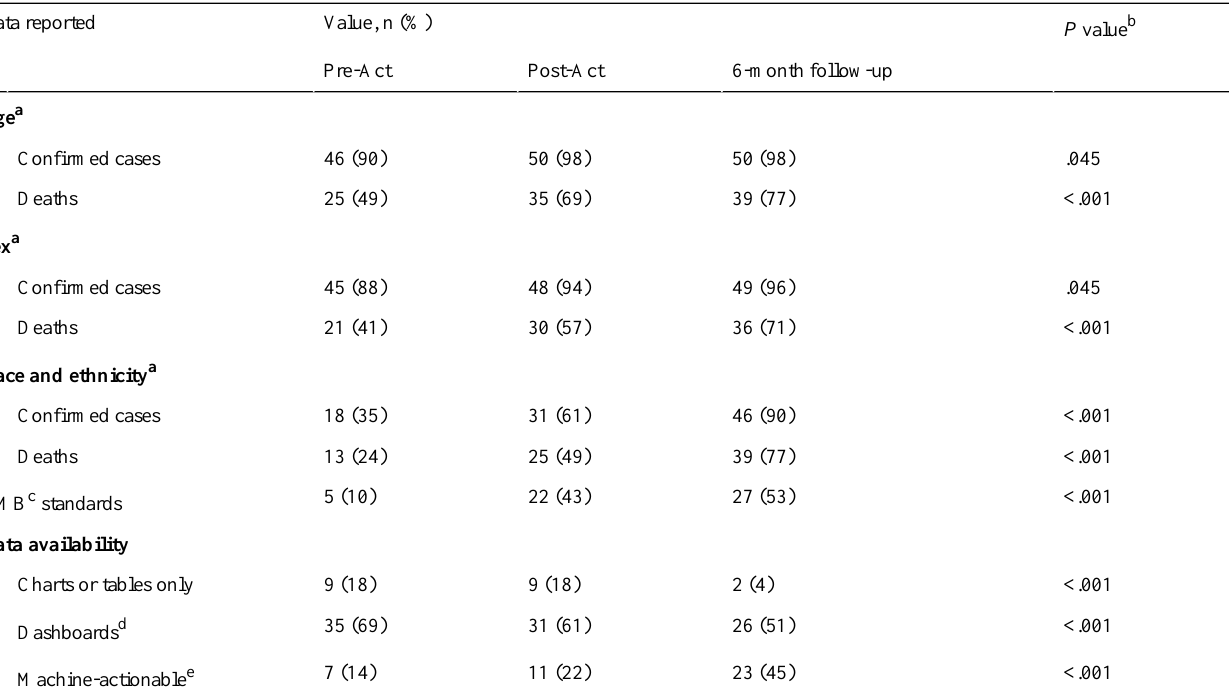
Table 1. Statistical comparisons of data reported before (pre-Act), immediately after (post-Act), and 6 months after (6-month follow-up) the introduction of the Equitable Data Collection and Disclosure on COVID-19 Act